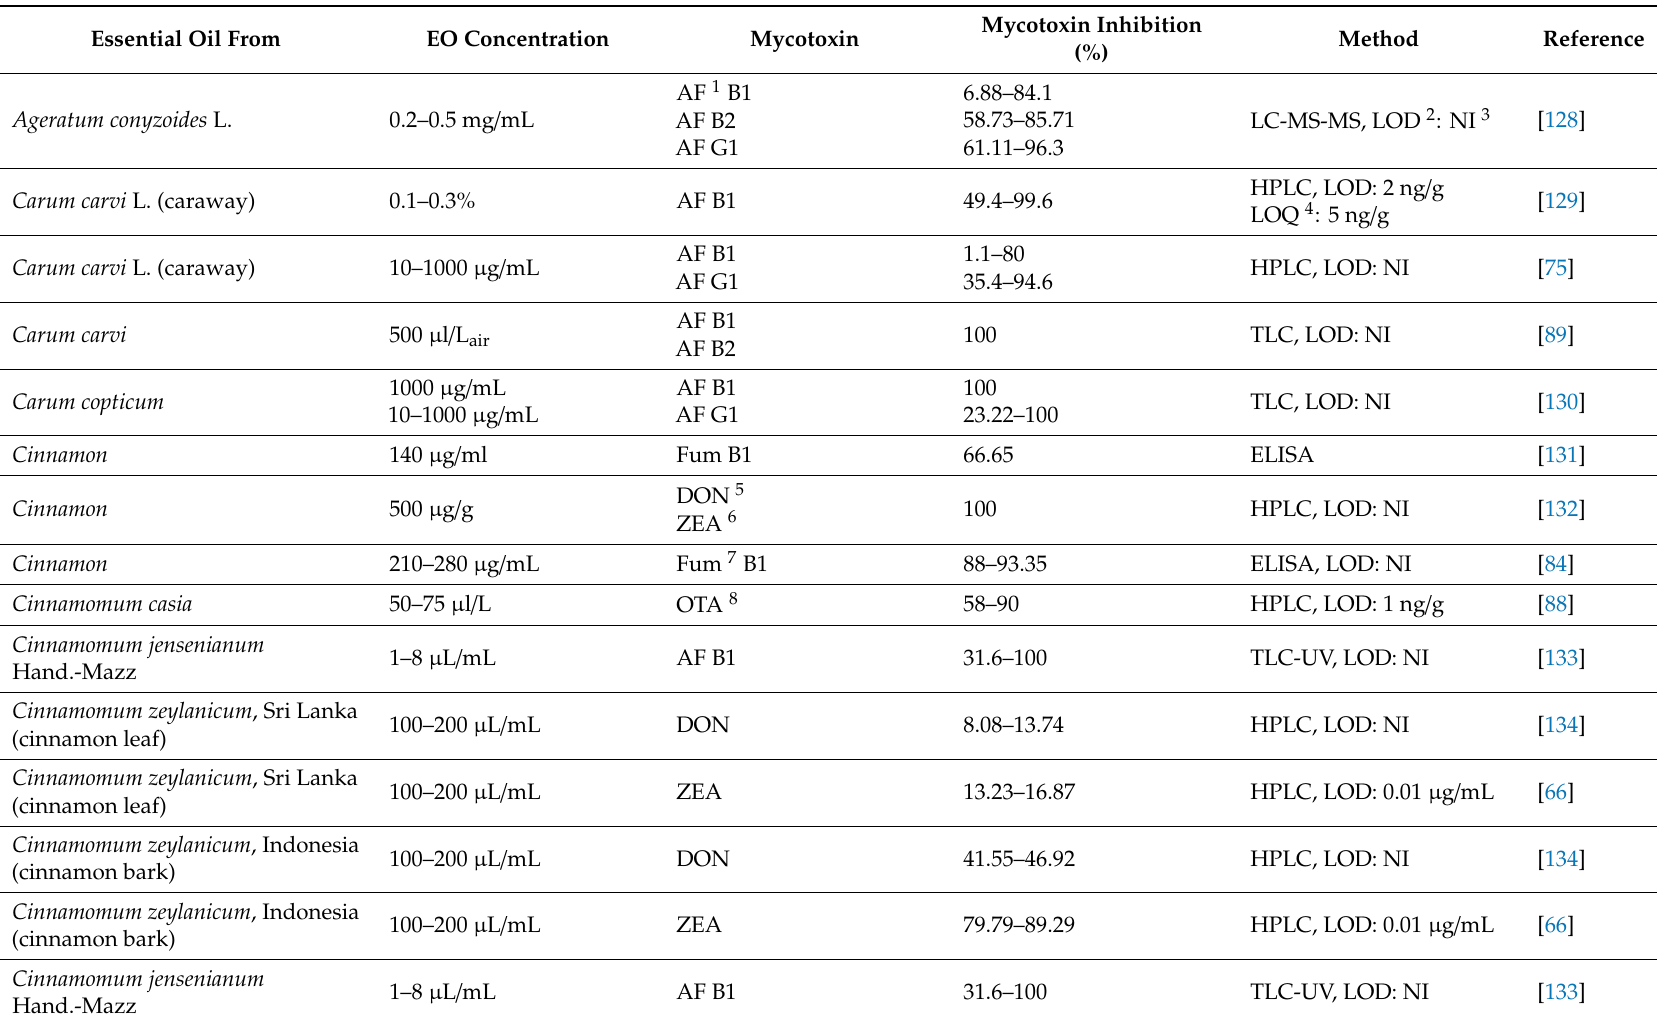
Table 3. Overview of studies about the antimycotoxigenic properties of essential